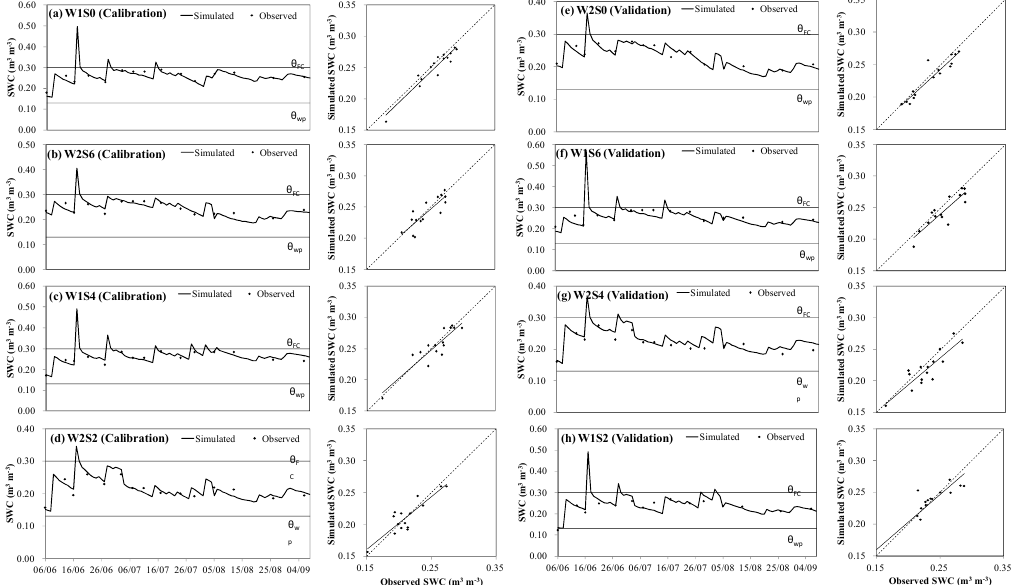
Figure 3. Simulated and observed soil water content ( SWC ) during the whole growth period of alfalfa in 2018: ( a ) W1S0, ( b ) W2S6, ( c ) W1S4 and ( d ) W2S2 for calibration; ( e ) W2S0, ( f ) W1S6, ( g ) W2S4 and ( h ) W1S2 for validation. On the right panel the corresponding regressions forced to the origin were shown. W1 and W2 indicated full irrigation and deficit irrigation. S0, S2, S4 and S6 indicated 0‰, 2‰, 4‰ and 6‰ mass ratio of salt per unit soil mass in the depth of 0–60 cm. The same as below. Table 2. Indicators of goodness of fit of soil water content ( SWC ) related to the SIMDualKc model calibration and validation for alfalfa.